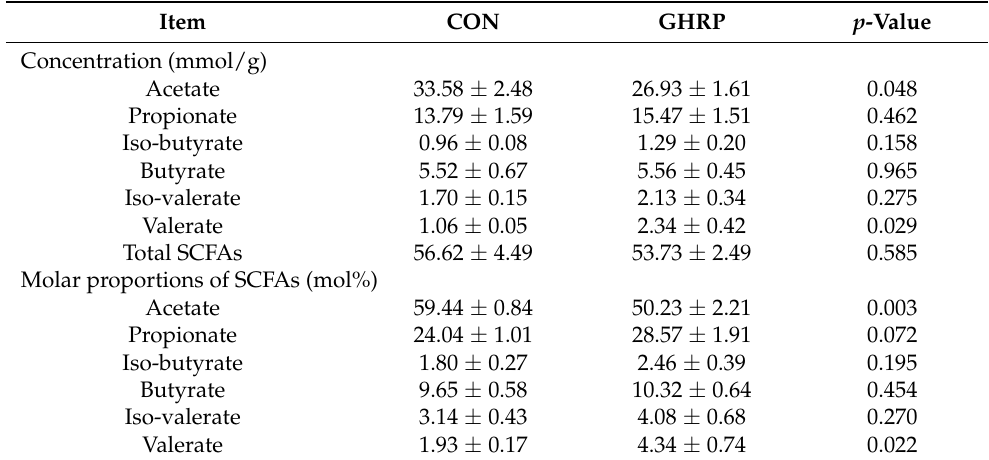
Table 1. Effect of injection of ghrelin antagonist ([D-Lys3]-GHRP-6) on the concentration and propor- tion of SCFAs in colonic digesta of pigs.